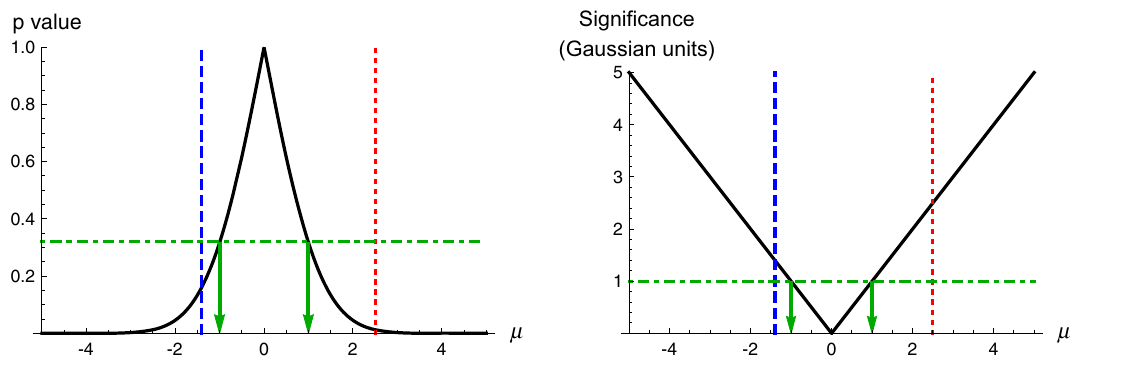
value larger than 0.32, as indicated by the green dotted dashed line and arrows . On the right the same information is expressed in Gaussian units of σ , where the 68% CL interval corresponds to the region below the horizontal line of significance 1